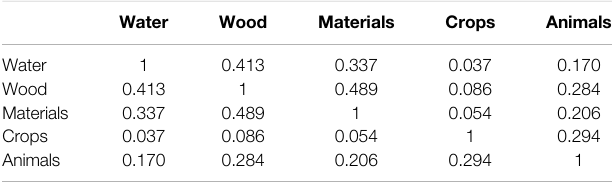
TABLE 3 | Correlation coef fi cients between the fi ve components of the characteristic bundle of ES. Water Wood Materials Crops